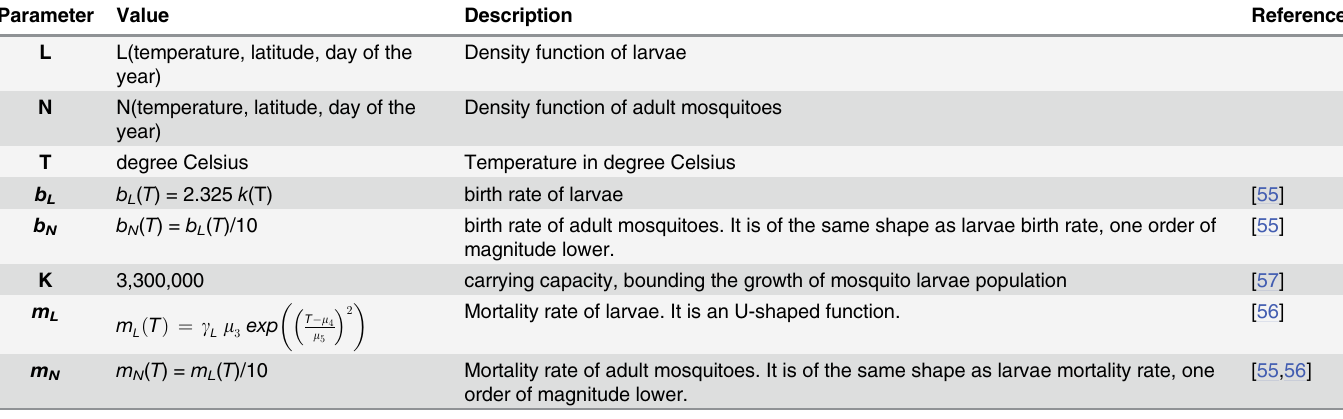
Table 1. Formulas, parameters, and references of the mosquito growth model: ordinary differential